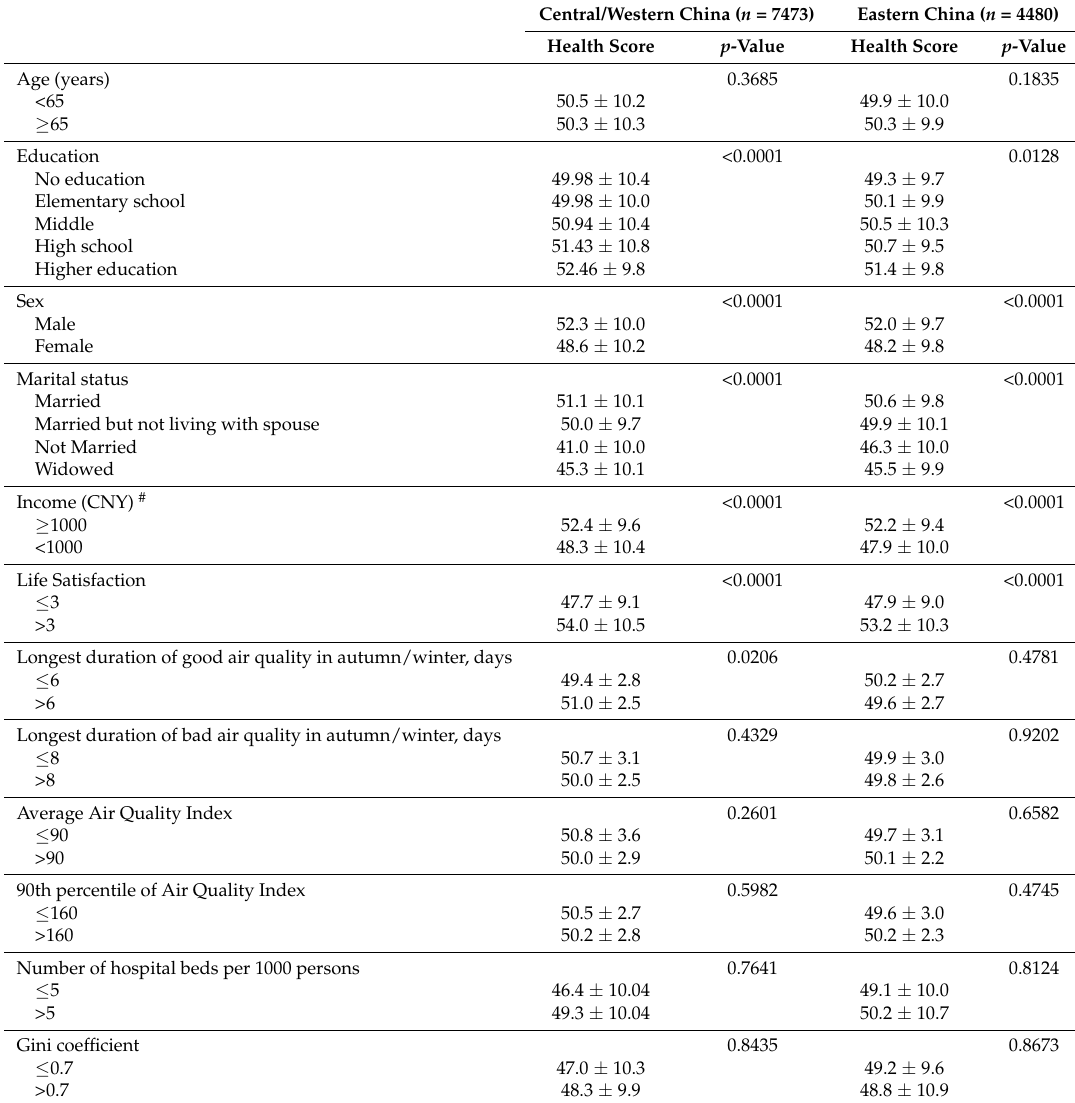
Table 2. Univariate analysis of the associations of participant demographic characteristics and air quality with health score by region.